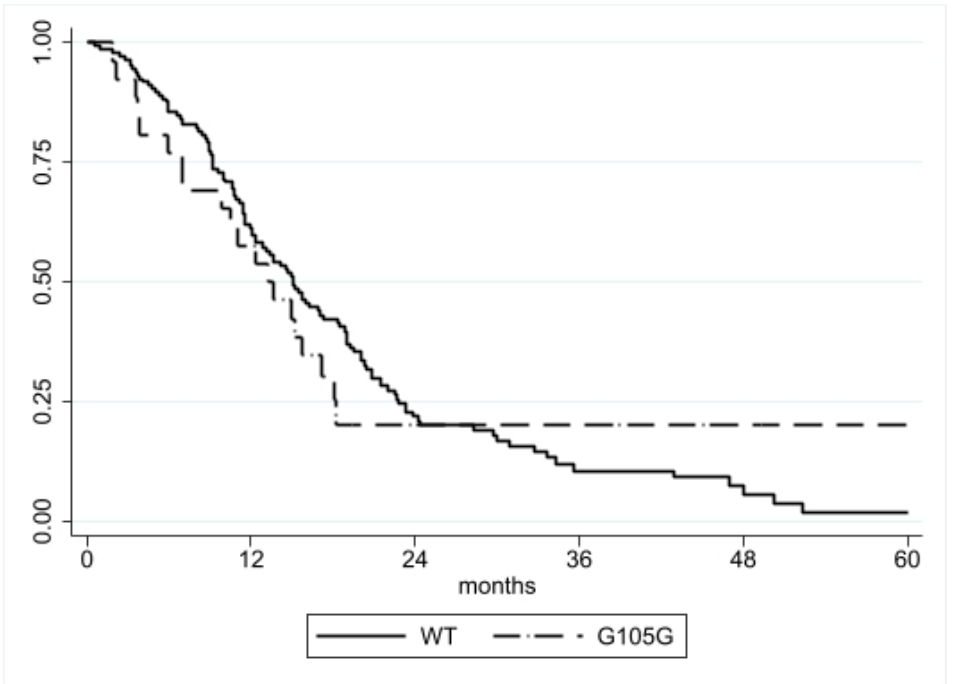
Figure 1. PFS according to IDH1 G105G status. No significant difference was detected ( p = 0.9770). Table 3. PFS analysis of clinical/pathological/molecular features by Cox regression.